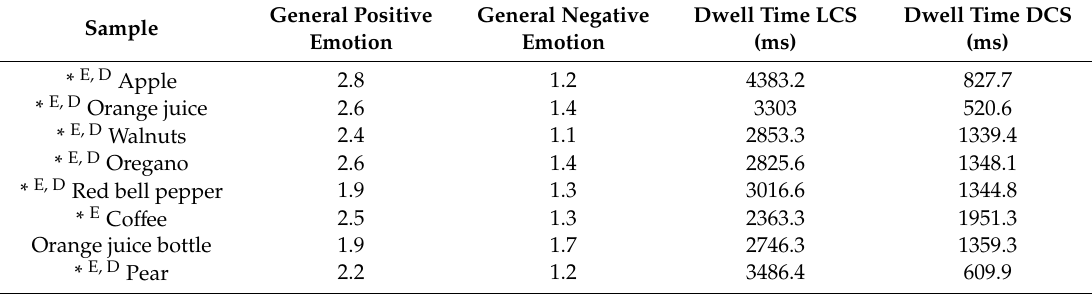
Table 3. Mean ratings of general positive and general negative emotions, and mean values of dwell time on the color scale. In addition to the significant di ff erences between GPE and GNE, and dwell time on the light colors versus the dwell time on the dark colors after testing each sample. General Positive General Negative Dwell Time LCS Dwell Time Sample Emotion Emotion (ms)